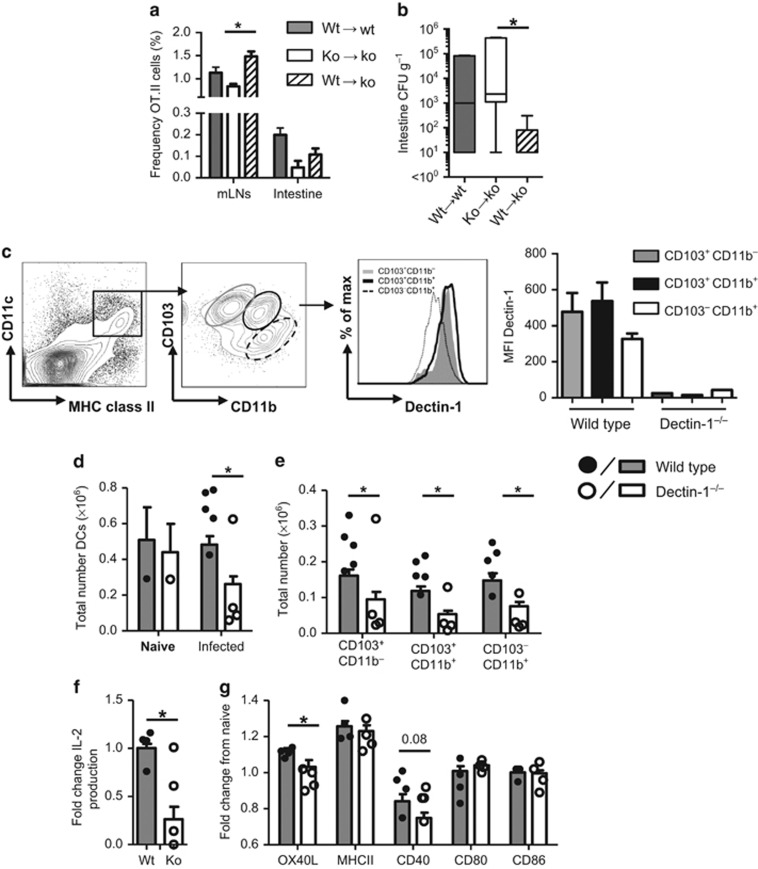
Loss of Dectin-1 causes defects in the DC response. (a) WT bone marrow restores the frequency of OT.II T-cells in the Dectin-1−/− mLN (WT→WT n=7, KO→KO n=5, WT→KO n=7) and small intestine (WT→WT n=3, KO→KO n=3, WT→KO n=4), and also leads to a reduction in (b) intestinal fungal burdens (WT→WT n=3, KO→KO n=4, WT→KO n=7). WT→WT denotes WT animals reconstituted with WT bone marrow. WT→KO denotes KO animals reconstituted with WT bone marrow. KO→KO denotes KO animals reconstituted with KO bone marrow. (c) DCs in the mLN were defined as B220−CD11c+MHCII+ (left panel), and migratory/resident sub-populations grouped into three sub-populations based on CD103 and CD11b expression (middle panel). Dectin-1 expression was assessed by staining with 2A1137 and analysis by flow cytometry (right panel and graph, n=4). (d) The number of total CD11c+MHCII+ cells (infected: WT n=29, KO n=23, naive: WT n=4, KO n=4) and (e) the migratory/resident populations (WT n=19, KO n=16) within the mLN at 72 h post infection in WT and Dectin-1−/− mice. (f) 4 × 104 CD11c+ cells from WT (n=8) and Dectin-1−/− (n=8) mice were purified from the mLN at 72 h post infection and cultured with 2 × 105 naive OT.II T-cells and 10 μg ml−1 OVA323-339 peptide. IL-2 in the supernatants was measured 24 h later and expressed relative to the WT. (g) FACS analysis of the indicated co-stimulation molecules relative to naive controls at 72 h post infection by CD11c+MHCII+ cells in the mLN (n=12). Bar charts show pooled data (chimera/IL-2: two experiments; DC data: five experiments); overlaid dot plots show one representative experiment. *P<0.05.